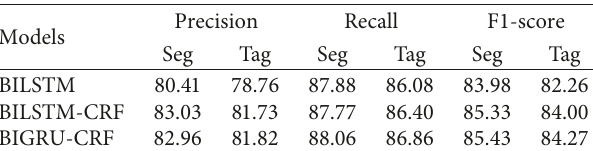
Table 4: Evaluation results of different model structures on the test